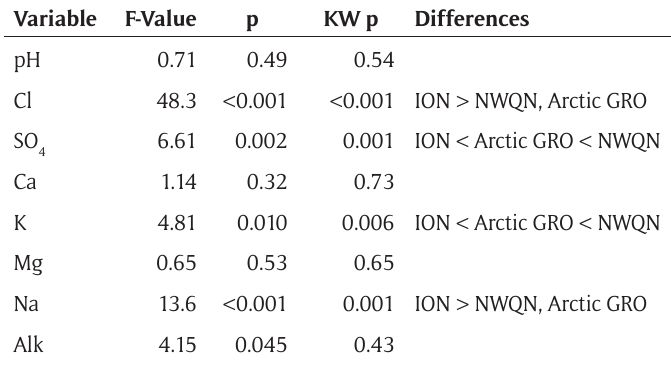
Table 6: Summary of One-way analysis of variance (ANOVA) and Kruskal-Wallis comparing the groups of collectors. If significant differences were found, the differences column indicates which specific differences were significant. [F-value, F-statistic associated with analysis of variance; p, Probability; KW p, Kruskal-Wallis probability; ION, Indig- enous Observation Network; NWQN, National Water Quality Network, Arctic-GRO, Arctic Great Rivers Observatory; <, less than; >, greater than].